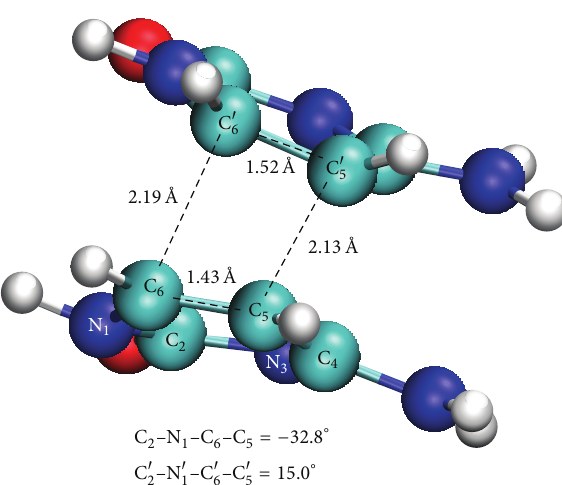
Figure 5: Geometries taken from trajectory at time of 976 fs, when avoided crossing occur.